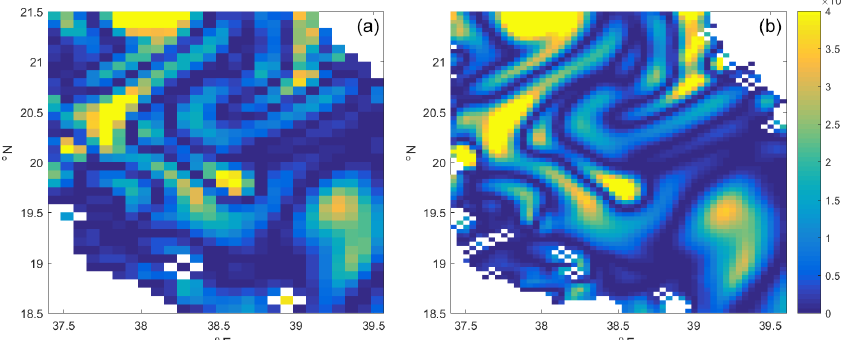
Figure 15. Enstrophy of surface currents in the central part of the Red Sea presented by eddy-permitting PHY_000_024 (a) and eddy- resolving SMORS (b) model: the white areas represent land and are different as the fine model uses finer-resolution bathymetry and coastline, which reveals more small